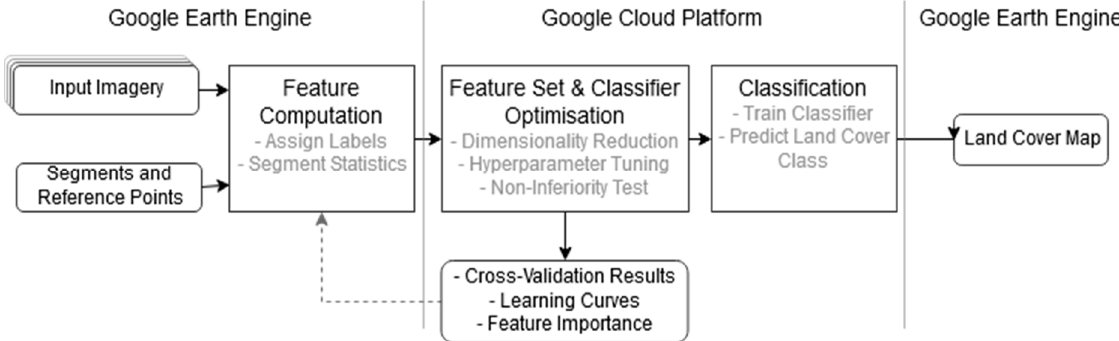
Figure 3. General workflow with the three-step approach of feature computation, classifier optimization, and classification.